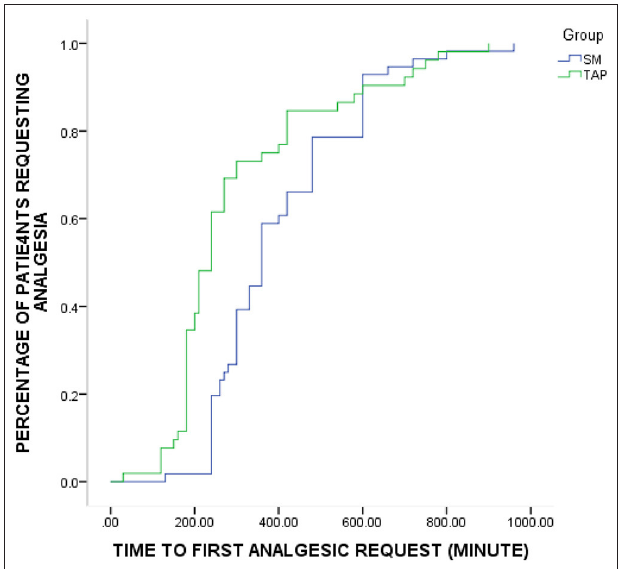
FIGURE 2 | Kaplan–Meier curve depicting the proportion of patients in each group over time who require supplemental analgesic ( p = 0.004, log-rank test). SM, spinal morphine; TAP, transversus abdominis plane.